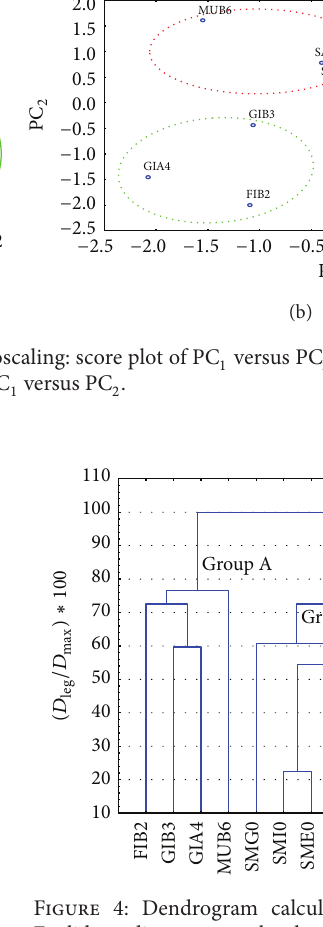
Figure 4: Dendrogram calculated by the Ward method with Euclidean distances on the dataset constituted by all the samples characterised at the selling time, after autoscaling. Samples are reported on the 𝑥 -axis while distance between samples/groups is reported as percentage on the 𝑦